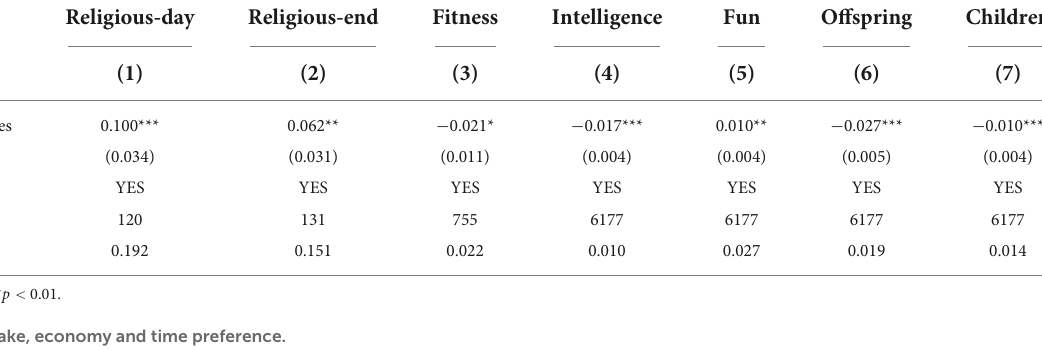
TABLE 10 Earthquakes and mindsets.